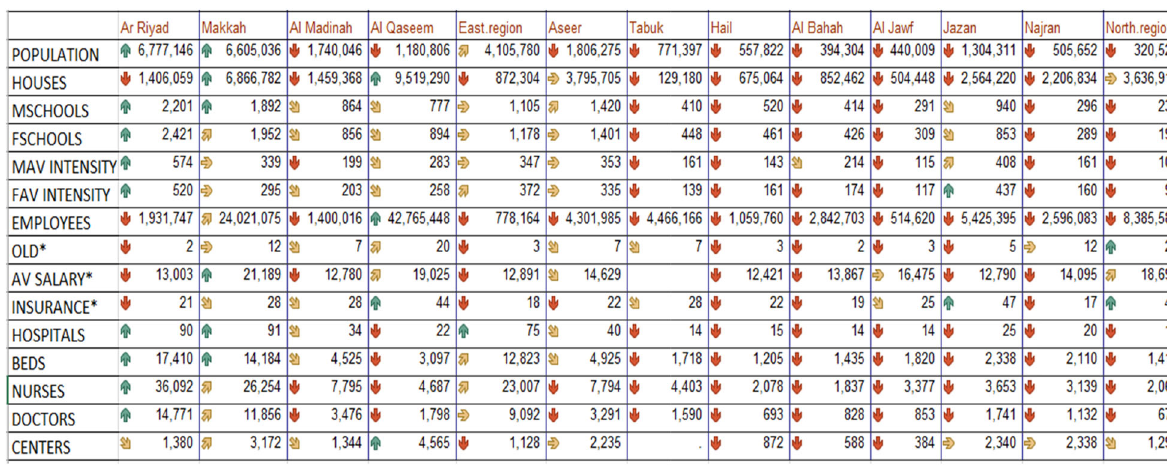
Table 2 Means of the study variables in KSA